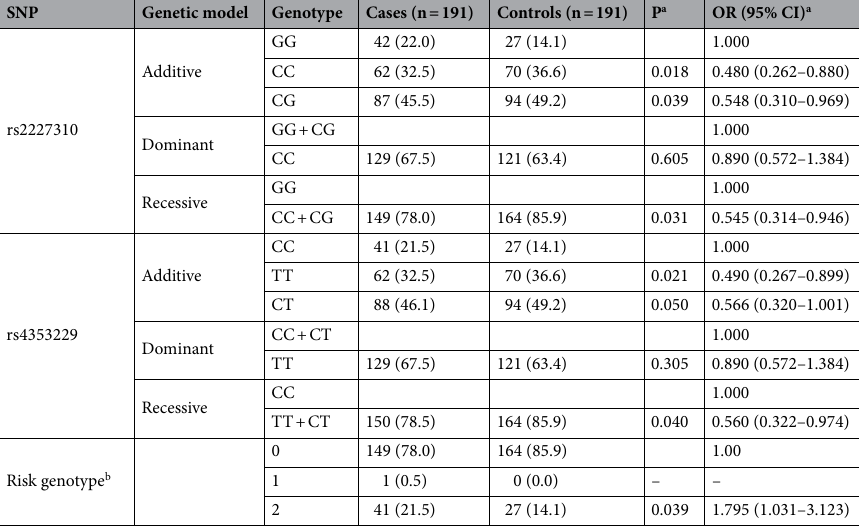
Table 2. Association between SNP and risk of NIHL. a Adjusted for age, marital status, personal monthly income, noise exposure time, wear noise protection products, smoking frequency, drinking frequency, diet taste, wear headphones to listen to music/watch videos, call time per day, length of one’s sleep, BMI, total cholesterol, triglyceride and CNE. b rs2227310 GG and rs4353229 CC genotype were classified as high-risk genotype; the number represents the numbers of the two genotypes within the combined genotype.